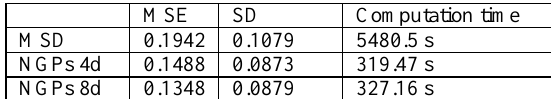
Table 4. Statistics of mean-square error (MSE) and standard division (SD) of height differences between MSD and NGPs compared with the LiDAR DTM as well as the time required to execute the